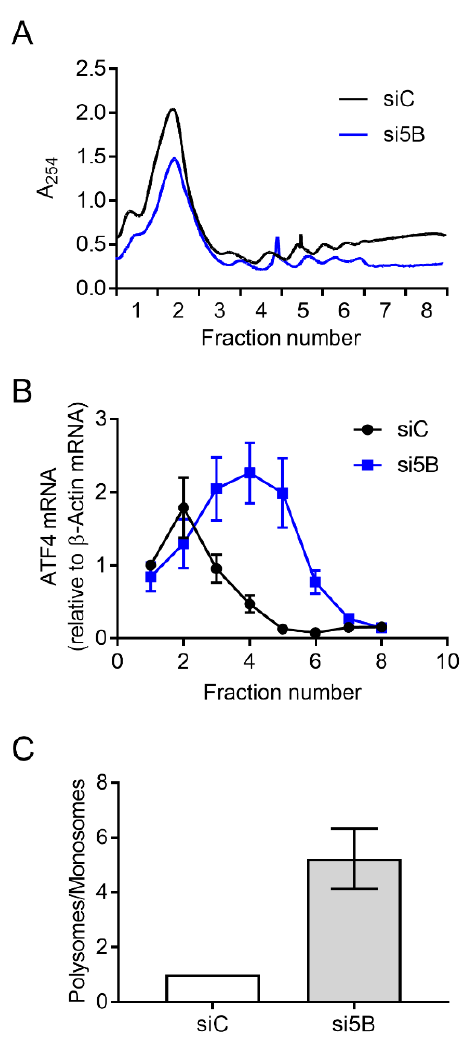
Figure 2. Depletion of eIF5B leads to increased translation of ATF4. HEK293T cells were reverse-transfected with a non-specific control siRNA (siC) or an eIF5B-specific siRNA pool (si5B), incubated 96 h, harvested in RNA lysis buffer, and subjected to polysome profiling analysis. ( A ) A representative polysome profile from control versus eIF5B-depleted HEK293T cells. ( B ) The proportion of ATF4 mRNA (relative to β -Actin mRNA) for each fraction from the panel ( A ). ( C ) Fractions 1–2 (representing monosomes) were pooled, as were fractions 3–8 (representing polysomes). The ratio of polysomes/monosomes is shown for a representative experiment. Data in panels ( B , C ) are expressed as the mean ± SD for technical triplicates. An independent experiment is shown in Figure S2.